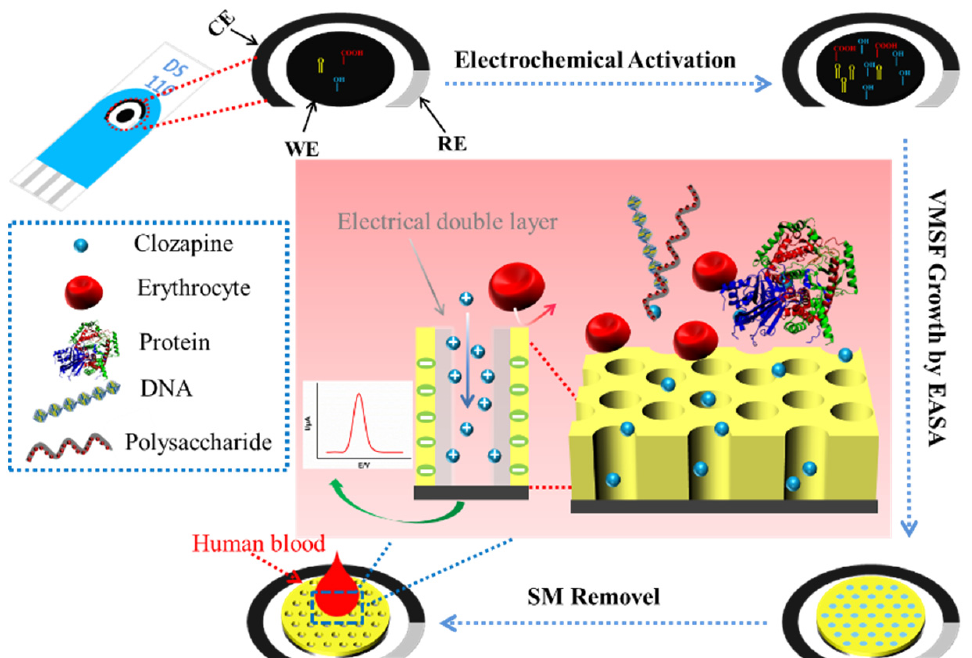
Figure 1. Schematic of the VMSF equipment on the electrochemically polarized SPCE and the direct determination of CLZ in human whole blood with high anti-fouling and anti-interference abilities. The cyclic voltammetry curves obtained in the electrochemical electrolyte or standard electrochemical probe solution (K 3 Fe(CN) 6 ) on SPCE before and after electrochemical polarization are shown in Figure 2a. Compared with SPCE, p-SPCE showed a significantly increased charging current (Inset in Figure 2a), indicating an increase in the electroactive area of the electrode through electrochemical polarization. In the case of a redox probe, p-SPCE exhibited higher peak current and lower peak-to-peak separation, showing an improved electron transfer rate after electrochemical polarization. This phenomenon